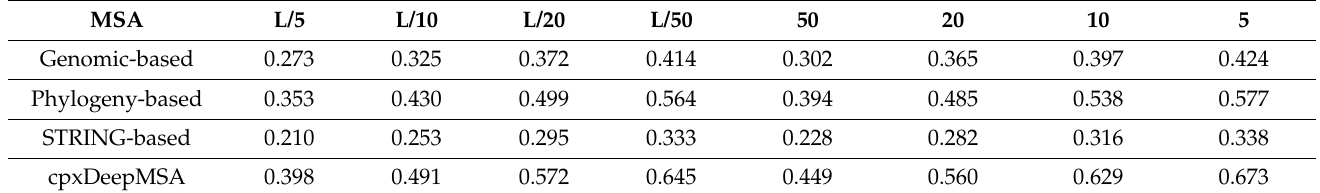
Table 1. Inter-protein contact prediction precision on the PDB100 database by trRosettaX. Bold font indicates the highest value in each category.